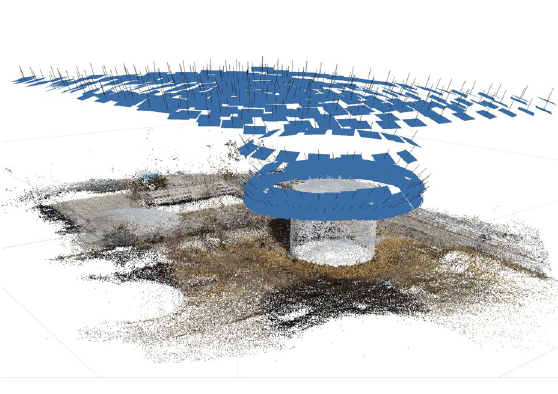
Figure 2. Point Cloud produced by UAV images BIM MODEL OF THE PETROLEUM RESERVOIR OF